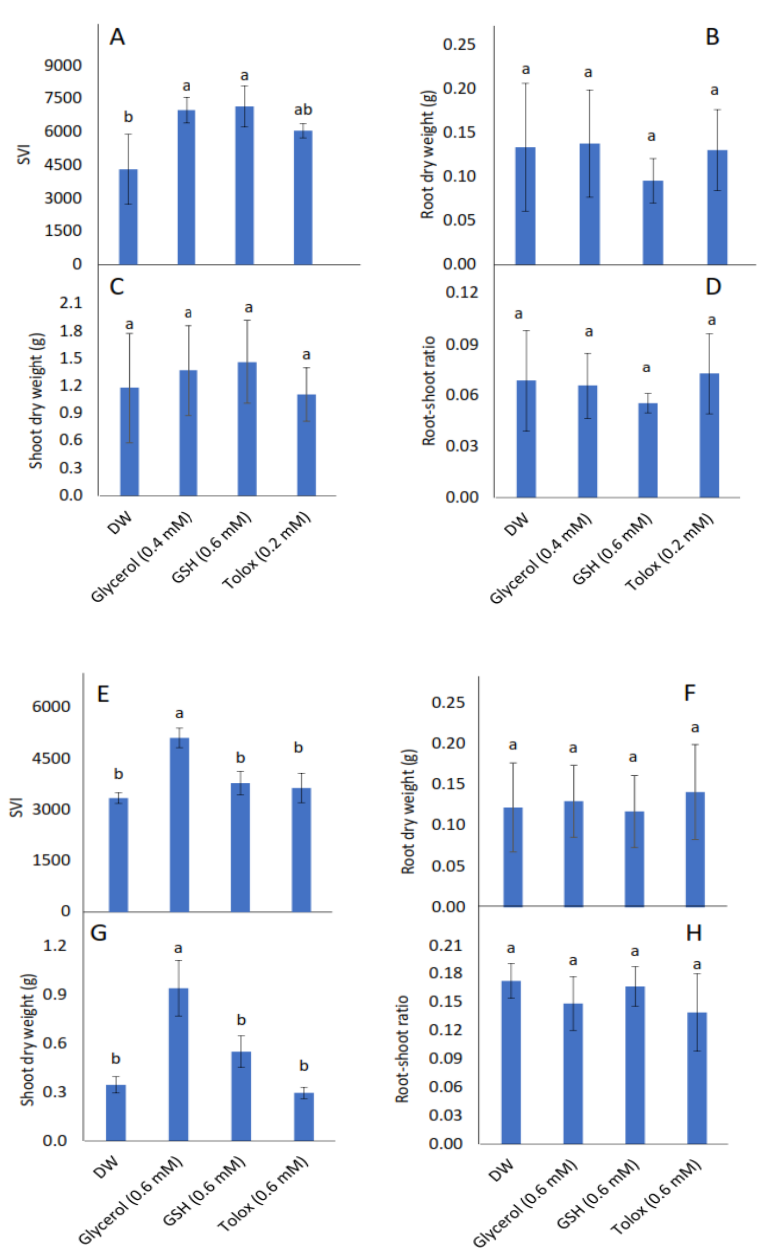
Figure 3. Effect of exogenous application of antioxidants on seedling vigour index (SVI) ( A , E ), root dry weight ( B , F ), shoot dry weight ( C , G ), and root:shoot ratio ( D , H ) in seedlings produced from P25 seeds of cabbage ( B . oleracea ) ( A – D ) and lettuce ( L . sativa ) ( E – H ) subjected to soaking in deionised water (DW), glycerol, glutathione (GSH) or trolox. Values represent mean ± SD (3 × n = 10). Bars labelled with different letters indicate significant differences ( p < 0.05, ANOVA).